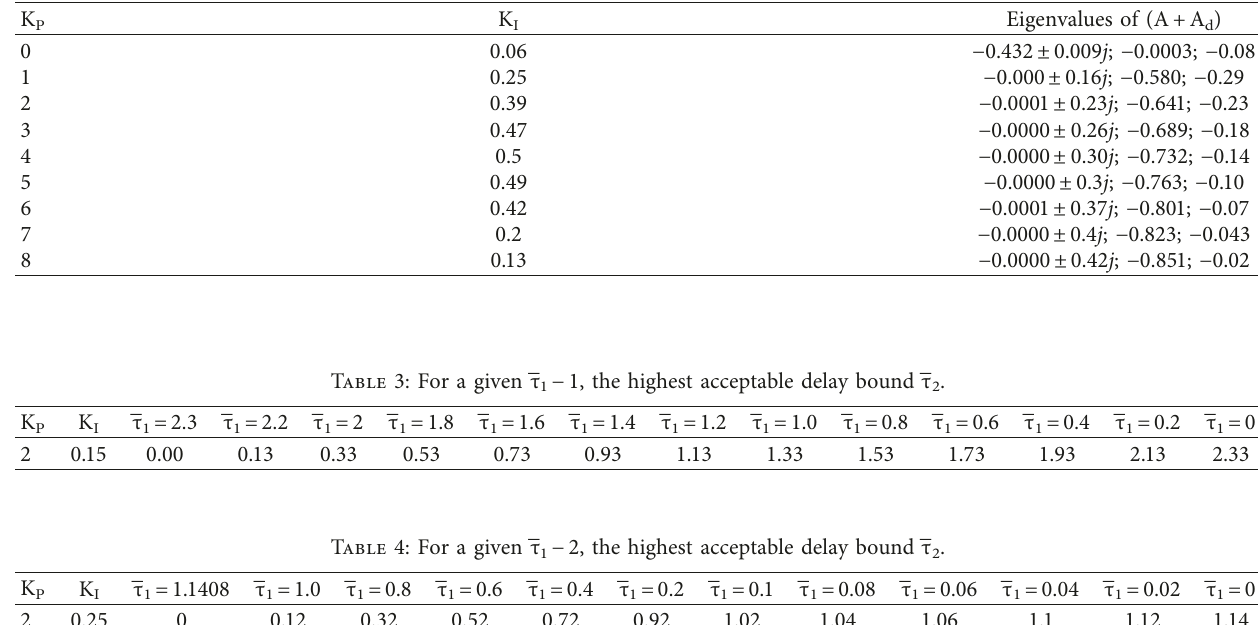
Table 5: For a given τ ̅